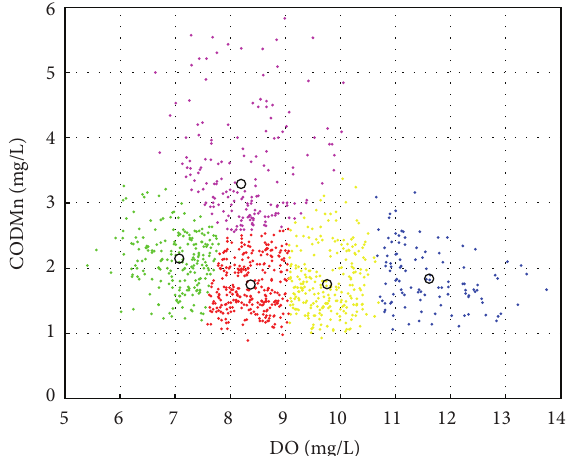
Figure 6: The distribution of water quality under the influence of DO and